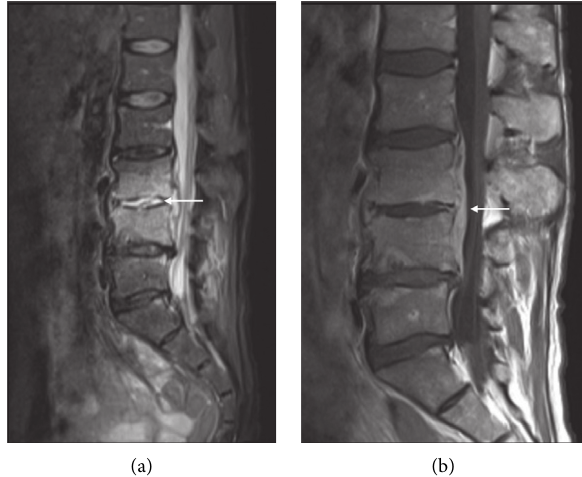
Figure 2: Discitis-osteomyelitis. (a) Sagittal STIR (short tau inversion recovery) with contiguous marrow oedema signal in the L3 and L4 vertebral bodies with involvement and effusion of the intervening L3/4 disc (arrow). Adjacent diffusely enhancing phlegmon (arrow) on a sagittal T1 postcontrast sequence (b) encroaching on the anterior epidural space, resulting in moderate spinal canal